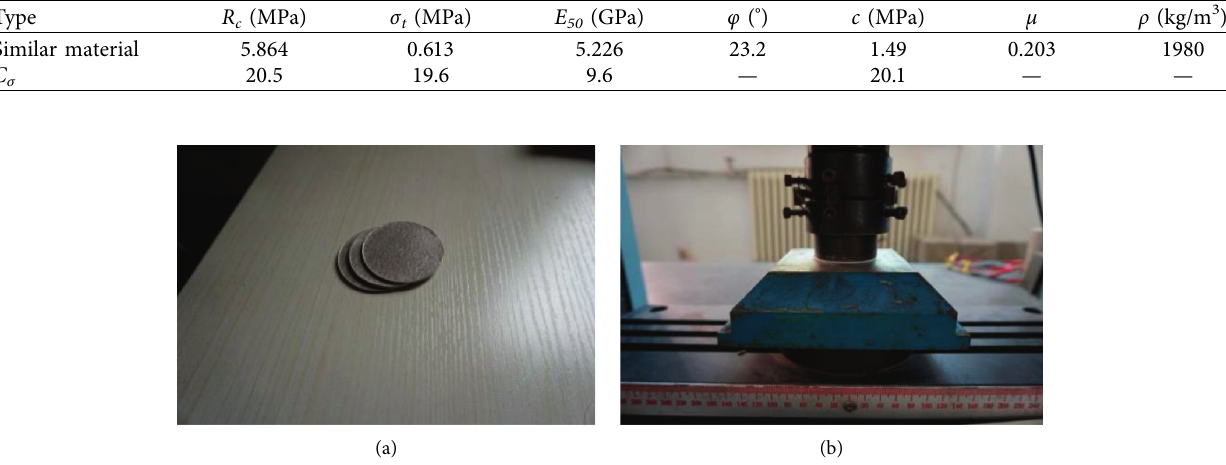
Figure 9: Normal mechanical properties test of the joint simulation material. (a) Circular mica plates. (b) Normal loading test.